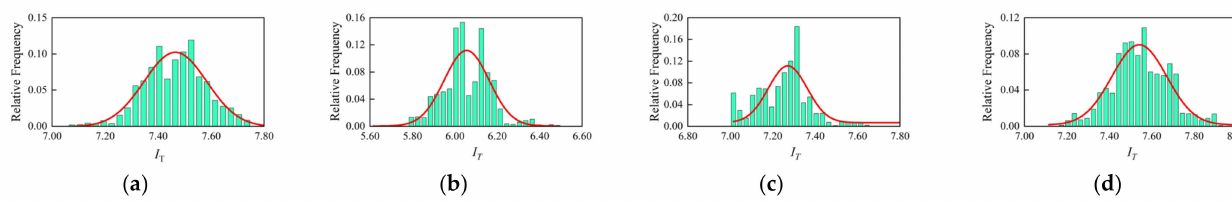
Figure 16. Posteriori relative frequency distribution of member 146. ( a ) Healthy; ( b ) failure of x - directional support restraint; ( c ) failure of y -directional support restraint; ( d ) failure of z -directional support restraint.